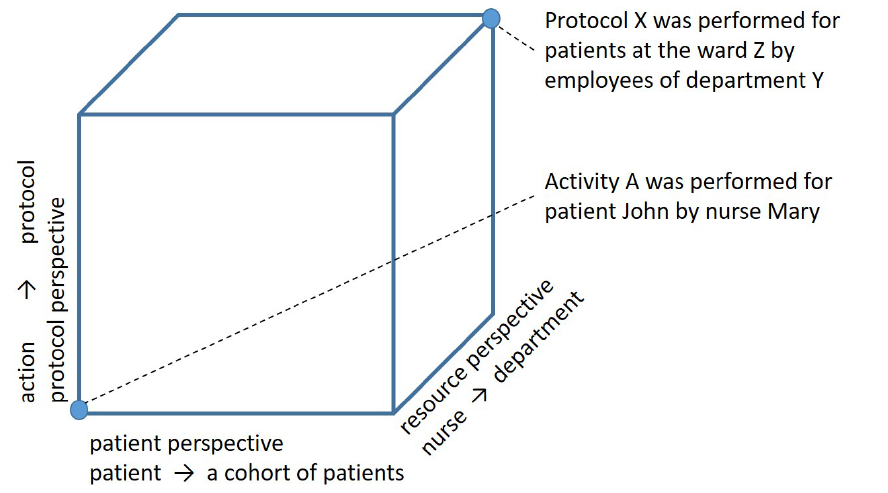
Figure 5. Three dimensions for a protocol compliance